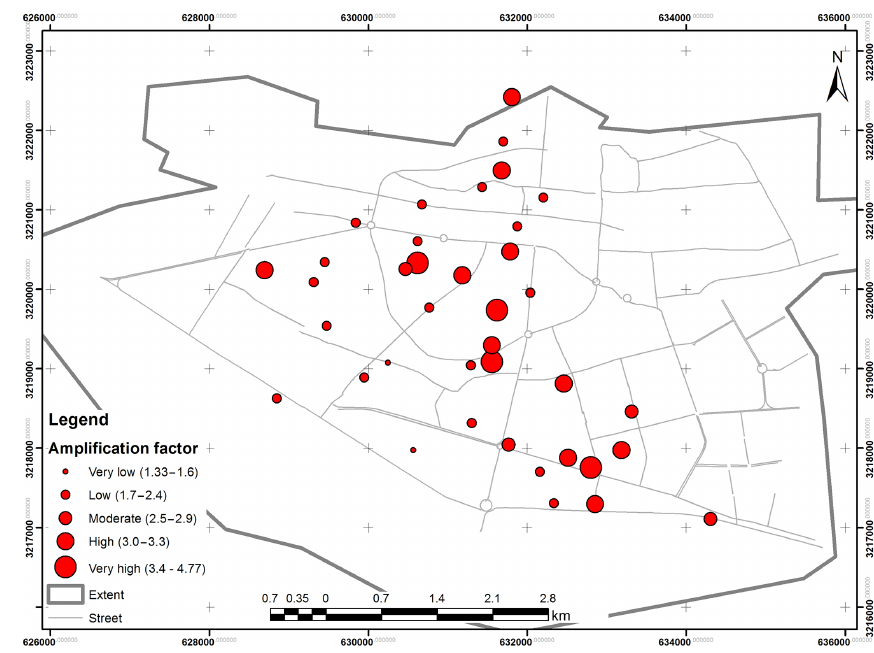
Figure 12. Control data: amplification factor by Motamed et al. (2007) using microtremor field measurements.